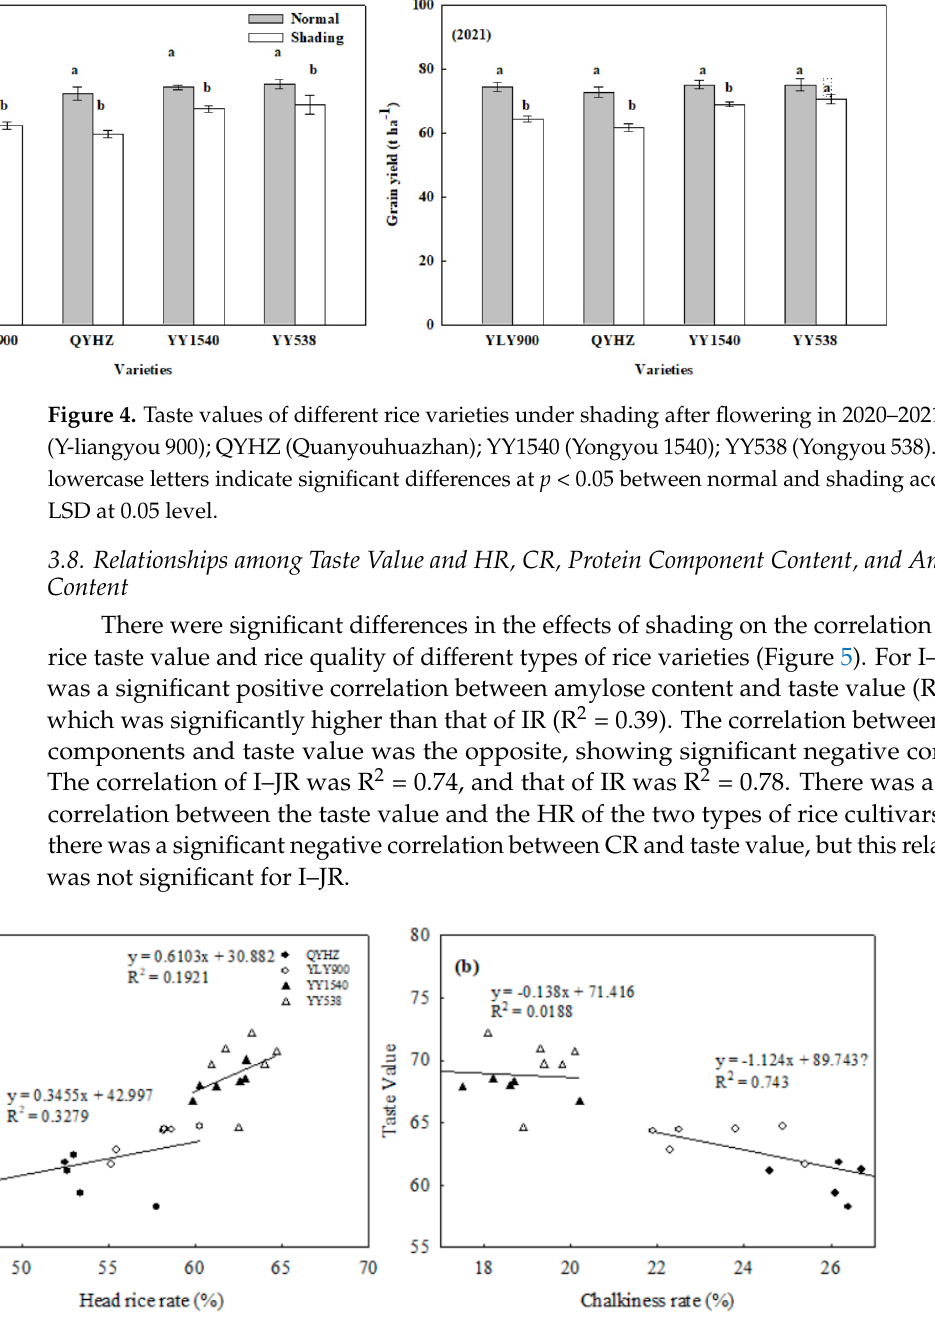
Figure 5. Correlation analysis of taste value and head rice rate ( a ), chalkiness rate ( b ), protein com- ponent content ( c ) and amylose content ( d ) of different rice varieties under shading after flowering in 2020–2021. YLY900 (Y-liangyou 900); QYHZ (Quanyouhuazhan); YY1540 (Yongyou 1540); YY538 (Yongyou 538). 4. Discussion Grain production is one of the most important issues in agricultural production. There are many studies on the impact of shading stress on rice [32]. Shading stress at dif- ferent growth stages could lead to stunted growth and development, reduce dry matter accumulation and the rate of assimilation of photosynthetic matter, and ultimately lead to a substantial reduction in rice yield [33,34]. For each growth stage, shading after flowering has the greatest impact on rice grain yield [35]. In this experiment, shading after flowering significantly reduced the grain yield of the two types of rice cultivars, and I–JR had better grain yield adaptability than that of IR under shading. In our previous study, we found that shading significantly reduced the grain filling percentage, which was the main reason for crop failure. Due to the inhibition of photosynthesis under shading stress, the “source” could not provide enough assimilates to meet grain growth, and the rice grain filling was insufficient, forming a large number of empty and half-filled grains, which greatly limited the grain yield potential [36,37]. In addition to the effect on the accumulation of photosyn- thetic substances, the shading stress after flowering also changed the transport and distri- bution ratio of photosynthetic substances. The decline in photosynthetic matter produc- tion capacity made grain filling rely on the output of assimilates accumulated in the stem and leaf before flowering, which significantly increased the dry matter output and output rate of stem and leaf. However, this increase in output could not completely offset the loss caused by the decrease in photosynthetic material accumulation, which led to a significant decrease in the amount of dry matter allocated to the rice panicles [38].